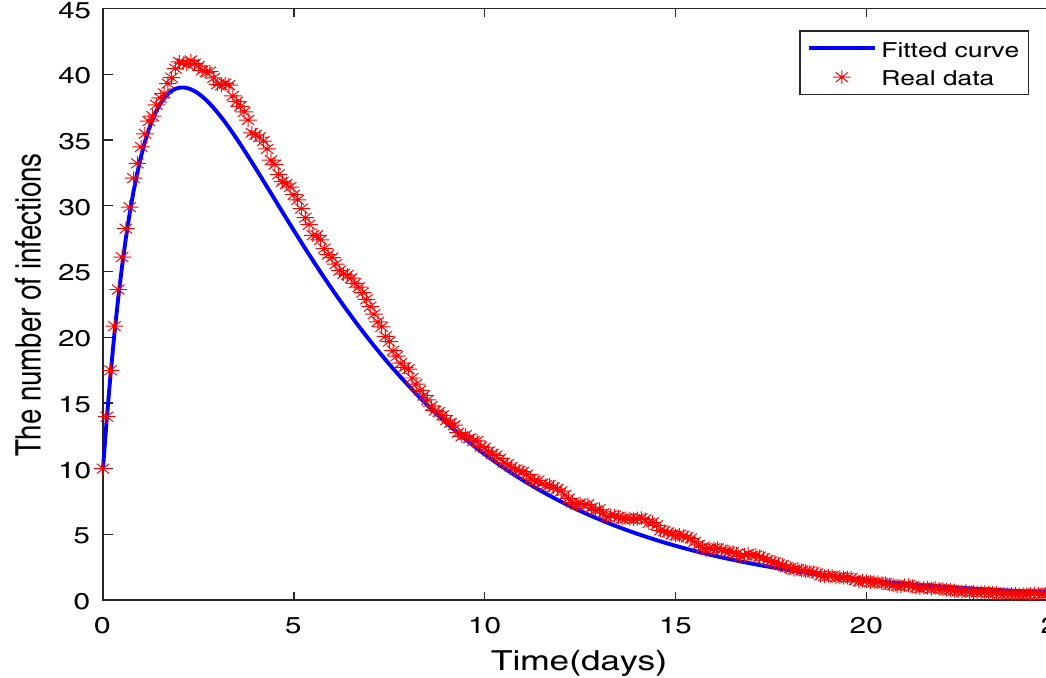
Figure 1. Quantity of the NoV infections compare with the numerical results of integer-order model